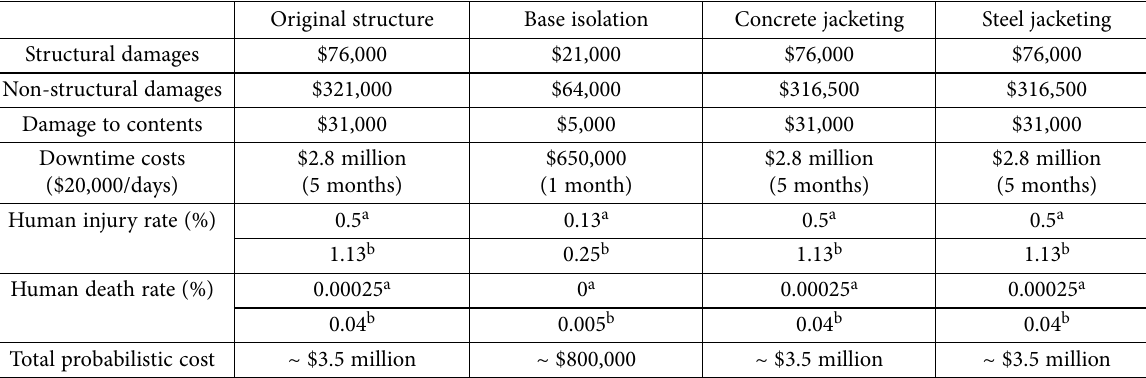
Table 5. Loss estimation for different retrofitting